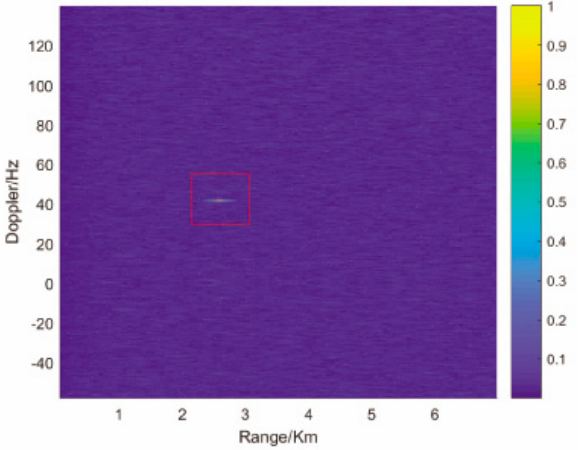
Figure 10. Coherent processing results based on the proposed method.